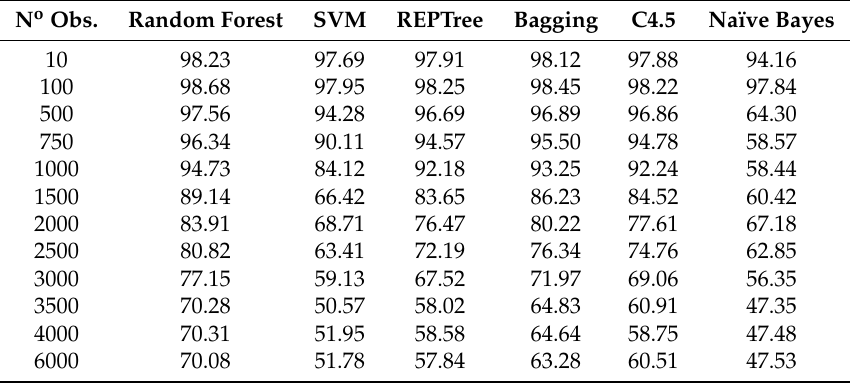
Table 3. Classification accuracy (%) for noise generation. N o